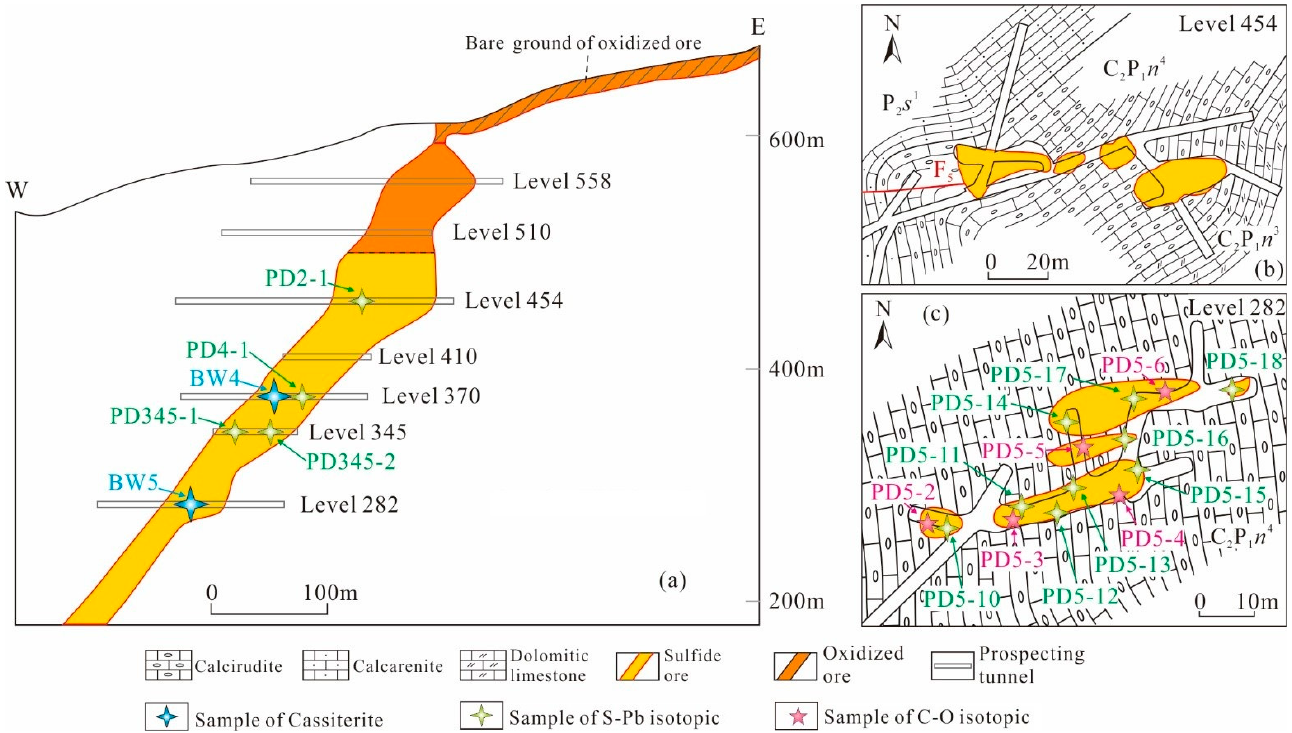
Figure 3. Vertical projection showing the regularity of side-pitching of the I ore body in Bawang deposit ( a ); geological plan of level 454 ( b ) and 282 ( c